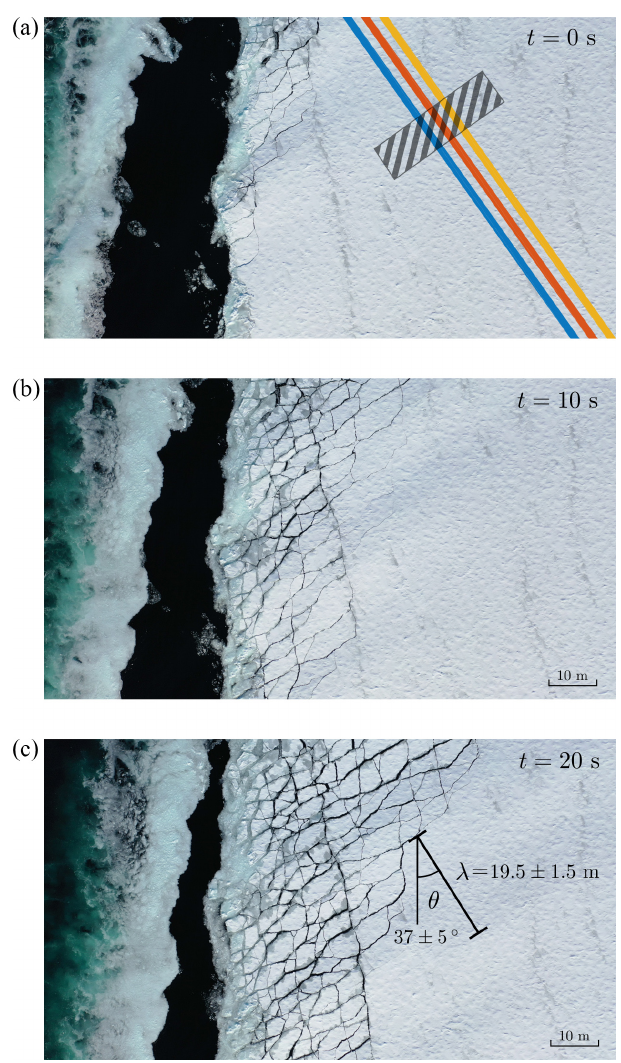
Figure 5. Snapshots of the wave-induced breakup experiment at t = 0, t = 10 and t = 20s. Waves are visible in the ice prior to breakup with λ = 19 . 5 ± 1 . 5m. Coloured polygons in panel (a) were used to calculate the breakup speed, and the dashed rectangle is the region of interest (ROI) used for the estimation of the wave